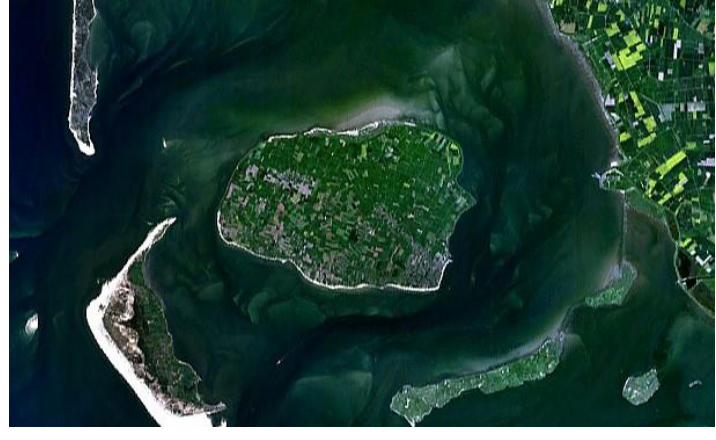
Figure 1 . Aerial image of